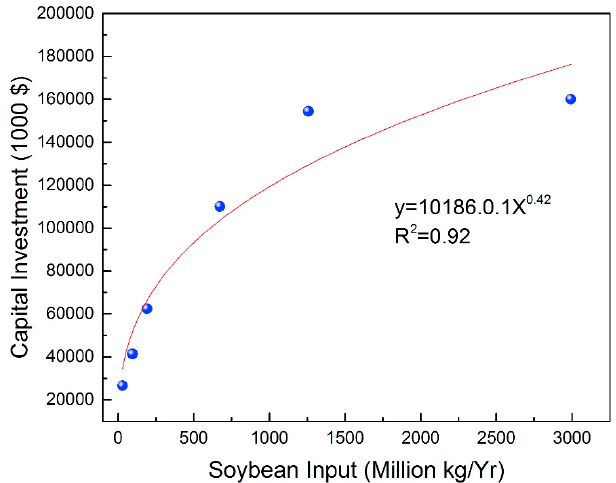
Figure 3. Non-linear relationship between total capital investment and various soybean input scales (i.e., processing capacities).